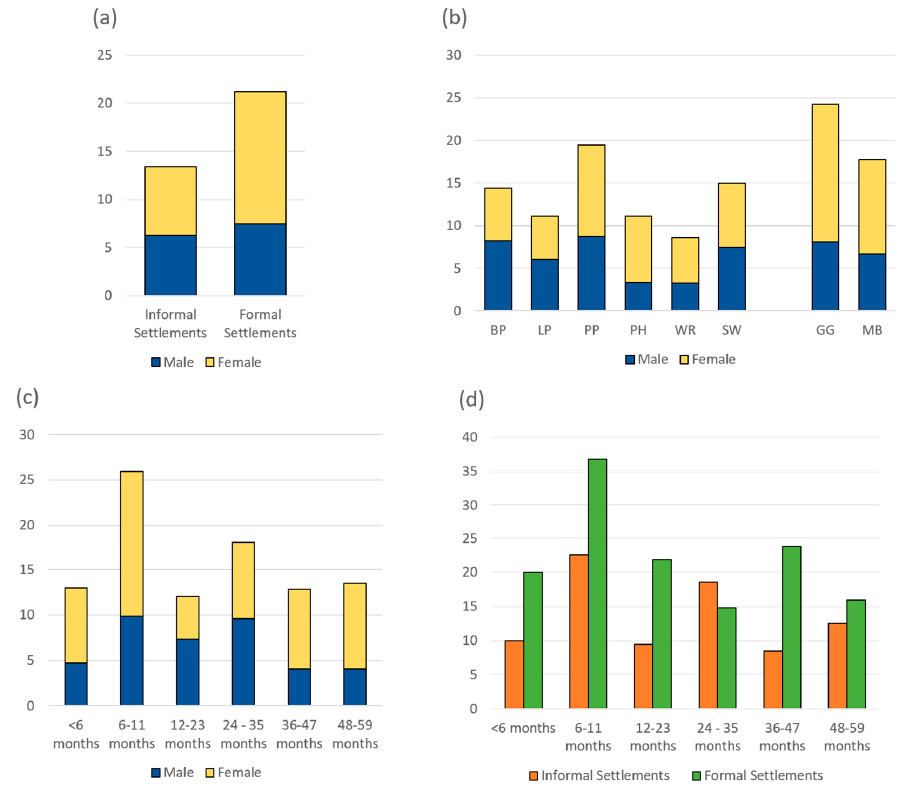
Figure 4. ( a ) The prevalence of diarrhoea cases by gender in each settlement type; ( b ) The prevalence of diarrhoea cases by gender in each study site; ( c ) The distribution of diarrhoea cases by gender in each age group; and ( d ) The prevalence of diarrhoea cases by house types in each age group. Note: BP (Barcelona Park), LP (Lotus Park), PP (Peligan Park), PH (Phola Park), WR (Weltevrede), SH (Sweet Home), GG (Gugulethu), and MB (Manenberg).